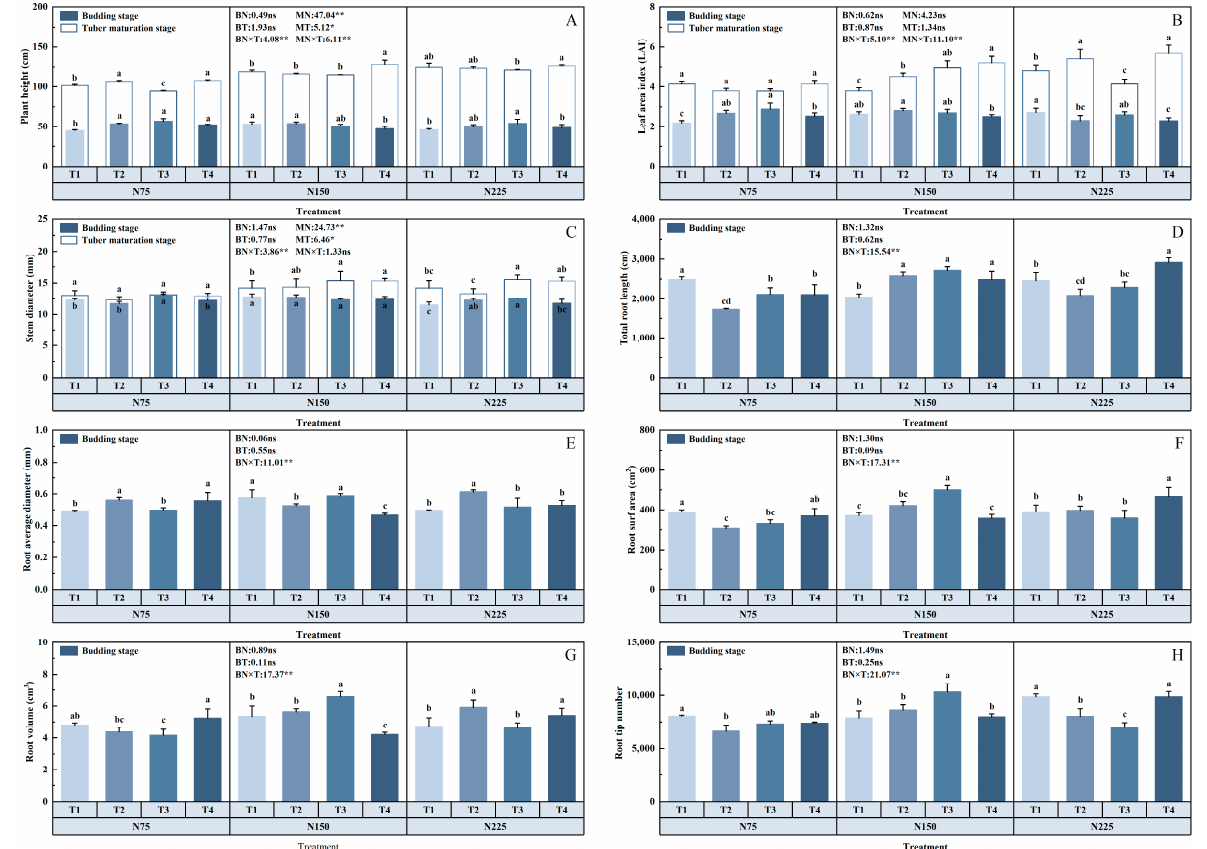
Figure 1. Agronomic characteristics of potatoes in different periods, plant height ( A ), LAI ( B ) and stem diameter ( C ) overground. Underground part of roots, total root length ( D ), root average diameter ( E ), root surf area ( F ), root volume ( G ) and root tip ( H ). Solid blocks represent the mean value of the budding stage and hollow blocks for the tuber maturation stage. Capital le tt er before F-value: B, budding stage; M, tuber maturation stage; N, nitrogen levels; T, base/topdressing ratio, the values refer to the F-value of ANOVA. Bars indicate standard errors ( n = 3), and di ff erent lowercase le tt ers indicate signi fi cant di ff erences between treatments ( p < 0.05). Ns, not signi fi cant, * p < 0.05, ** p < 0.01.